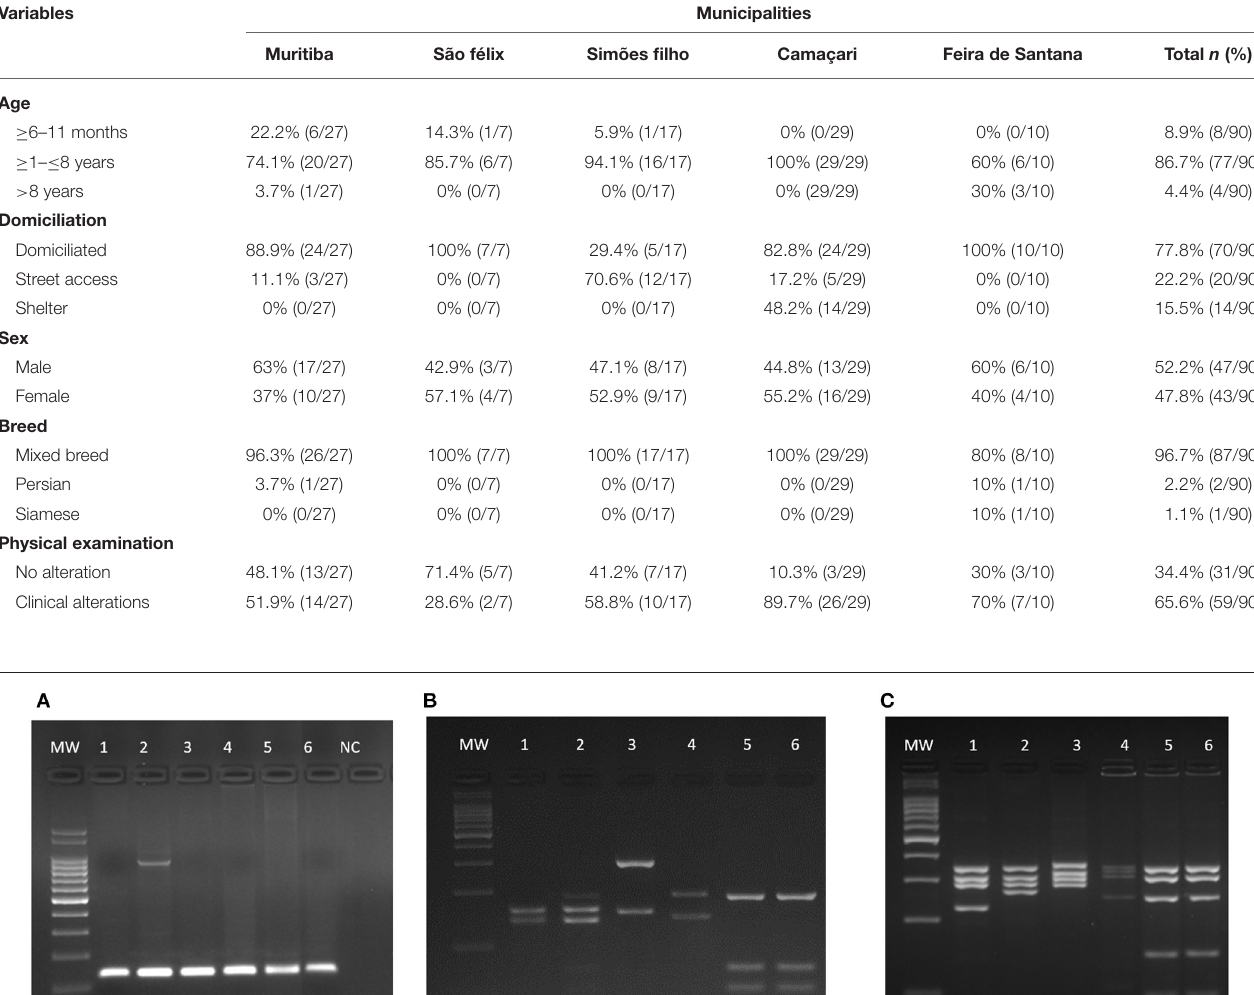
TABLE 2 | Parameters of the feline population in the five surveyed municipalities for L. infantum in the state of Bahia, Brazil (July, 2018 to December, 2019). Variables